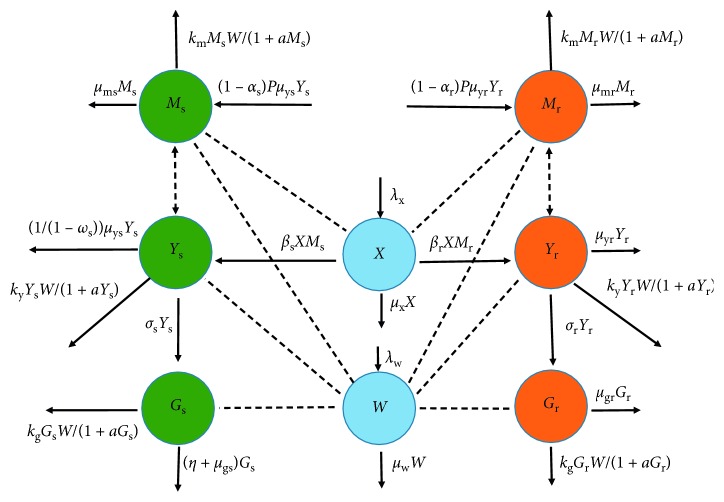
A model flow diagram. Drug-sensitive variables are shown in green colours while the drug-resistant variables are indicated in orange colours. Non-strain-specific variables like susceptible RBCs and immune cells are shown in blue colour. Solid lines indicate the movement of populations from one compartment to another. Dotted lines show possible interactions between the different populations.